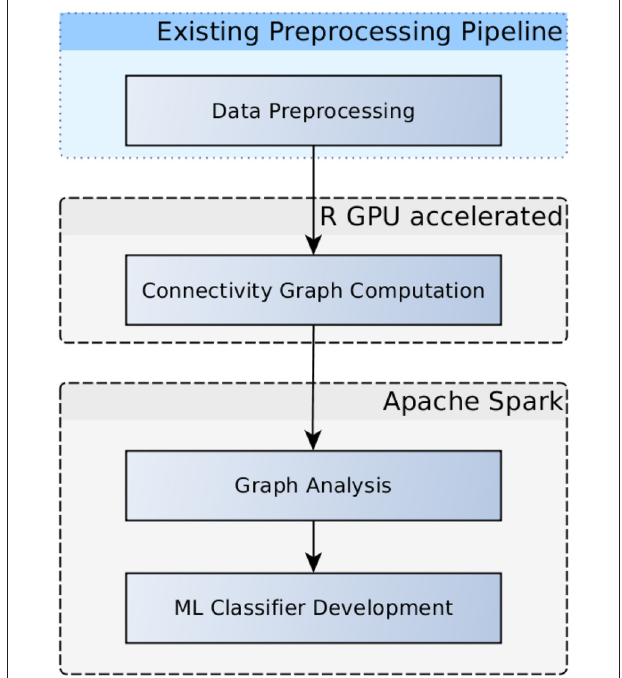
FIGURE 3 | Flowchart depicting an examplary analysis workflow. Graphs based on voxelwise functional connectivity can be computed using the GPU accelerated R package. Graph measures using graph theory results can be extracted in Apache Spark, subsequently, these measures can be fed into the development of machine learning